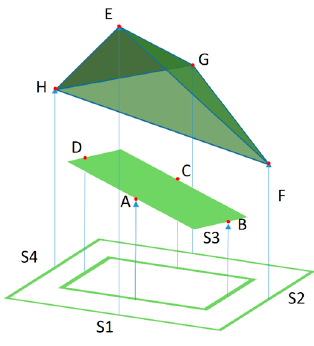
Figure 13. Compliant wrist kinematic configuration estimation.